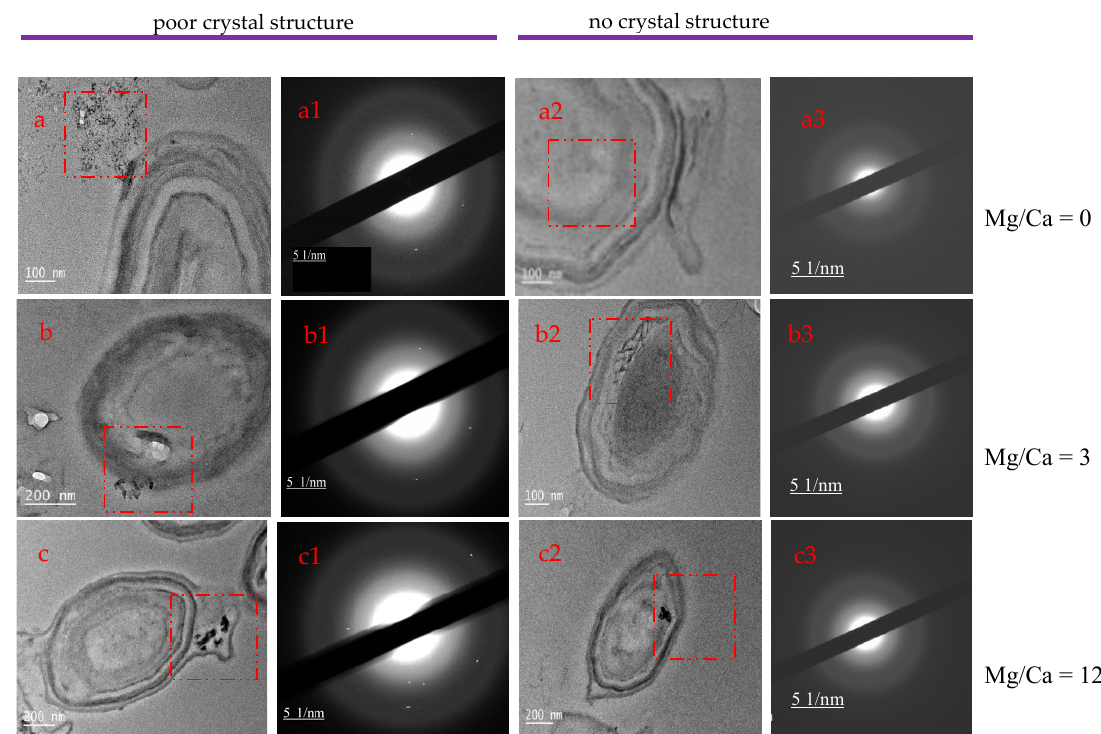
Figure 10. The dark clumps composed of alternating light and dark bands within the EPS of B. licheniformis analyzed by HRTEM and SAED. (a–c) images of the dark clumps analyzed by HRTEM, (d) SAED image of the dark clump marked by the yellow circle in (a).